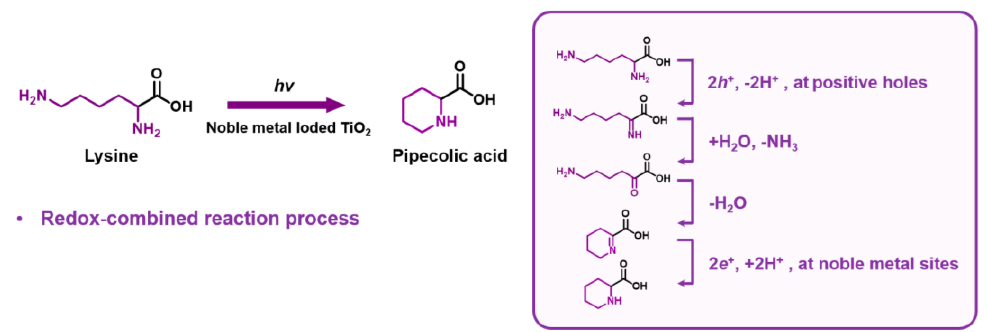
Figure 5. Production of pipecolic acid from lysine.